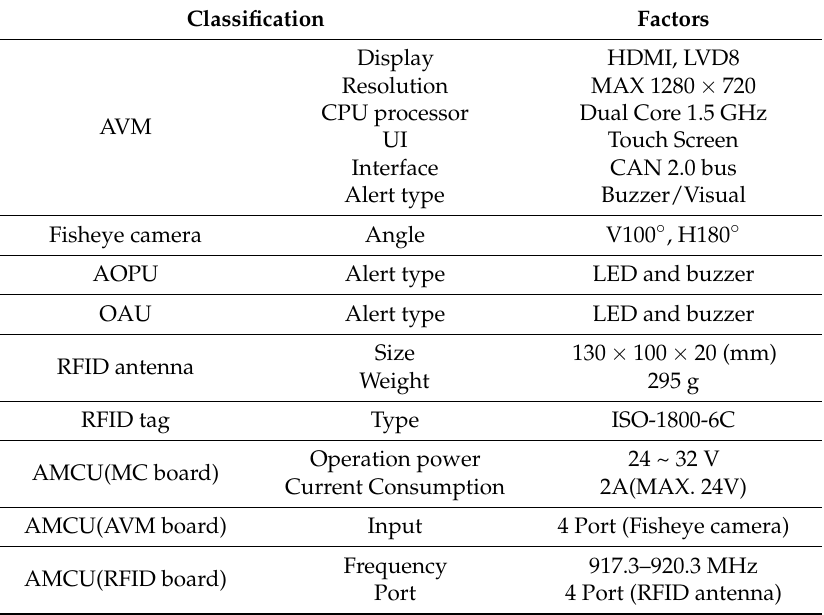
Figure 10. Hardware-software of ACAS and GRMS. Table 7. Specifications of ACAS.